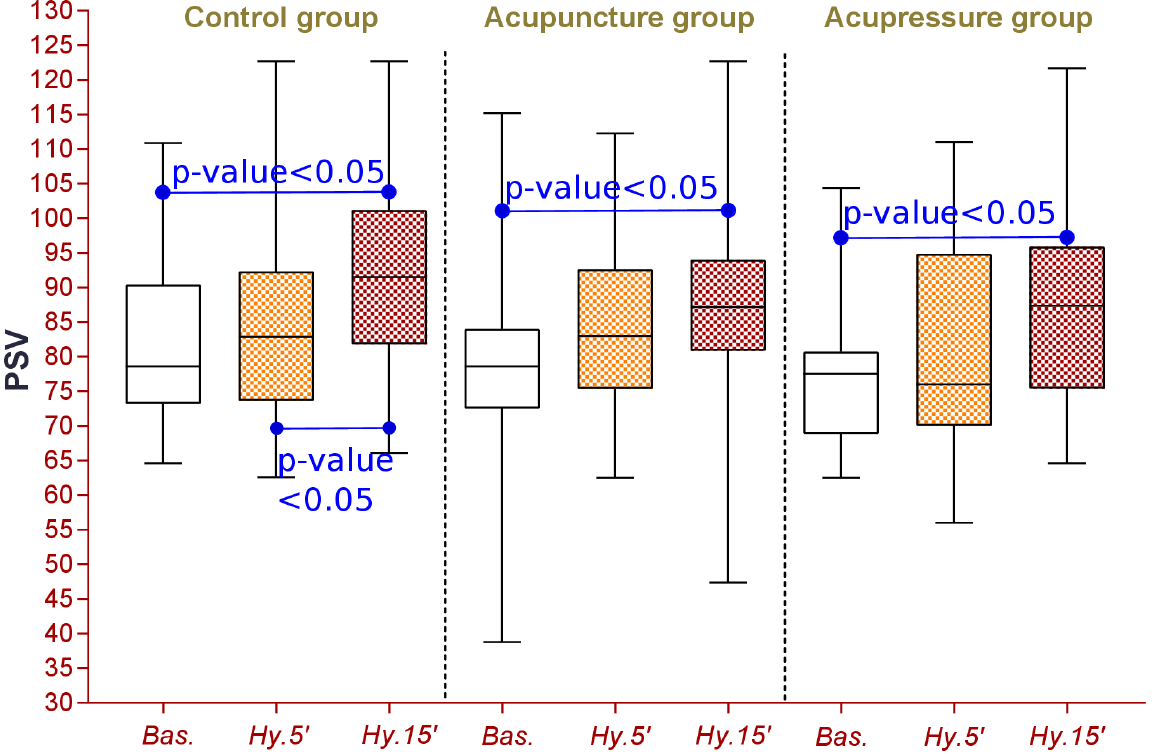
Figure 5. Centimeters per second peak systolic velocity (PSV) in control, acupuncture, and band (acupressure) groups at baseline and after 5 and 15 min of hypoxia.